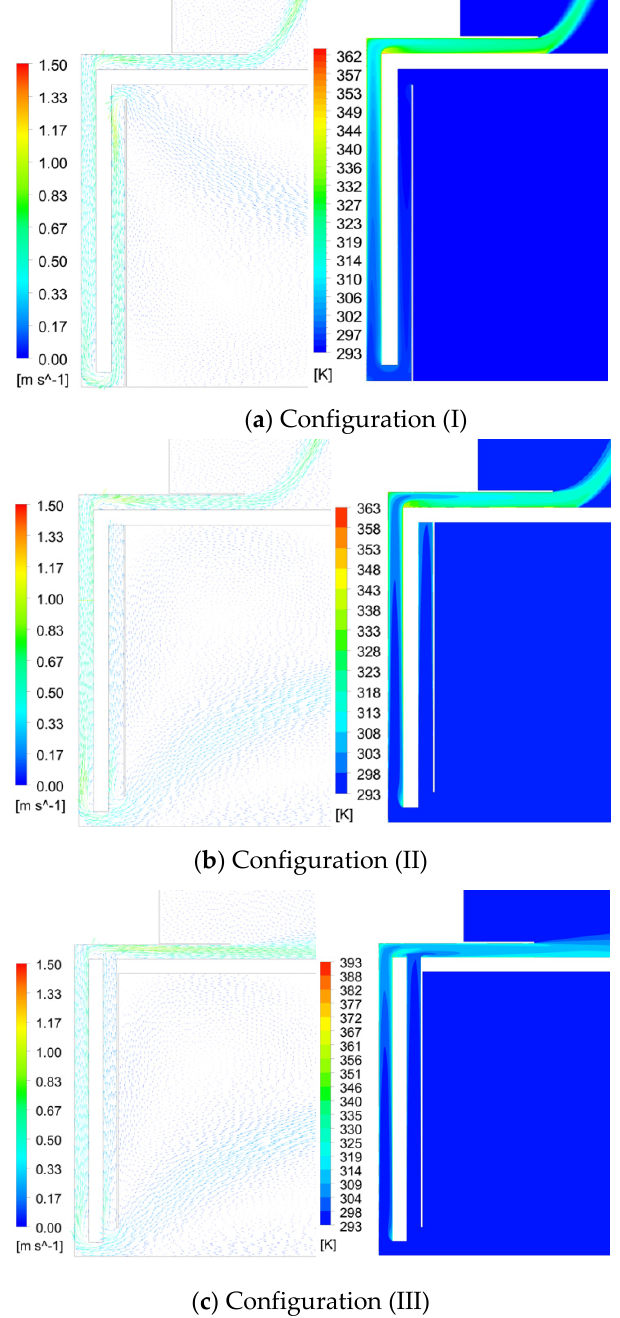
Figure 4. Distributions of the flow velocity and temperature ( 𝑞 (cid:2869) = 500 𝑊/𝑚 (cid:2870) , 𝑞 (cid:2870) = 100 𝑊/𝑚 (cid:2870) , 𝐺 (cid:2869) = 𝐺 (cid:2870) = 0.1 m ). G 1 = G 2 = 0.1